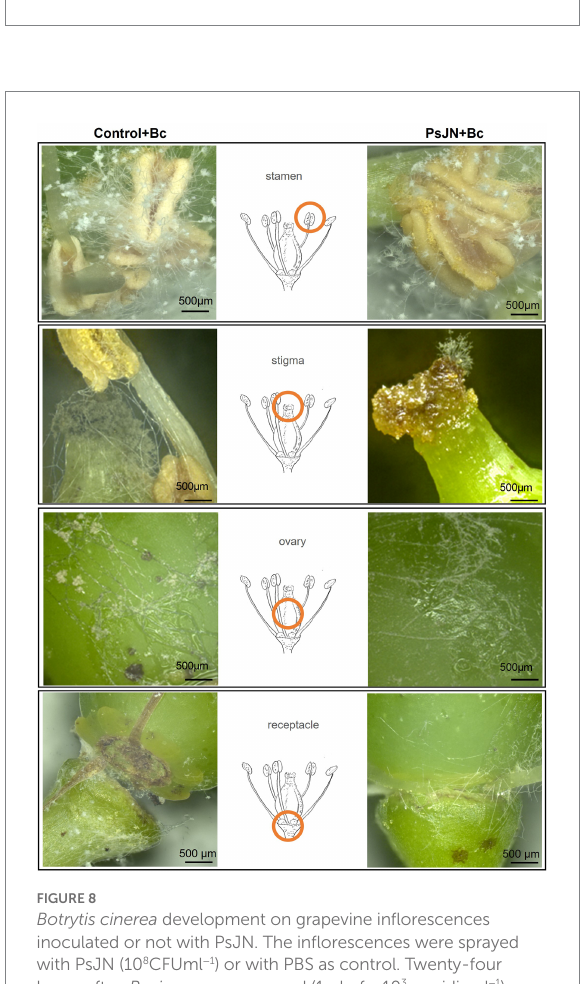
FIGURE 8 Botrytis cinerea development on grapevine inflorescences inoculated or not with PsJN. The inflorescences were sprayed with PsJN (10 8 CFU ml − 1 ) or with PBS as control. Twenty-four hours after, B. cinerea was sprayed (1 ml of a 10 3 conidia ml − 1 ). 3D-microscopic observations were realized 72 hpi by the fungus on different parts of the flowers. Scale bars = 500 μ m.